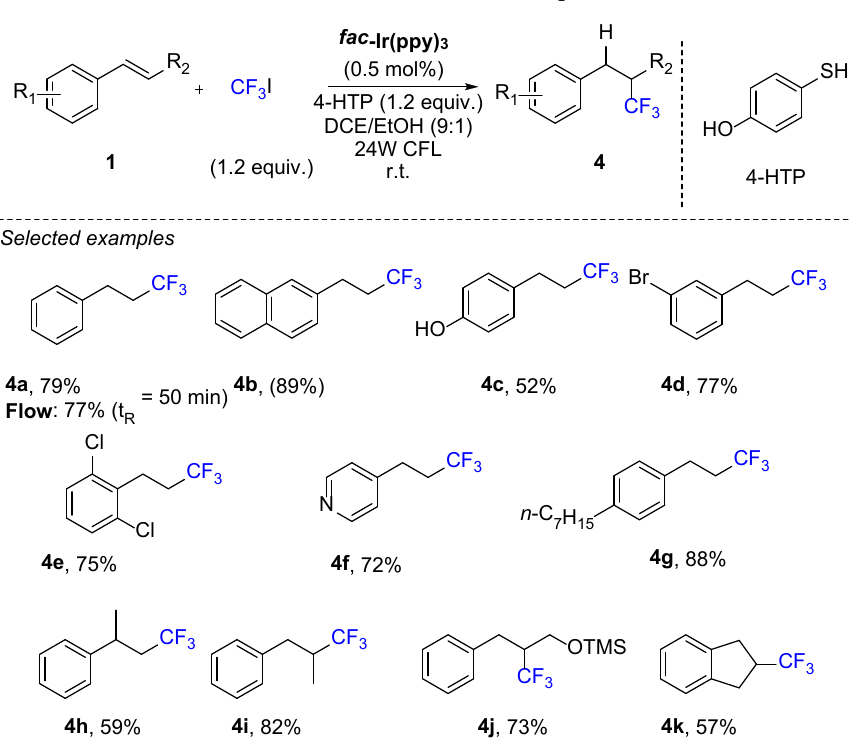
rene derivatives. Their visible light protocol is based on the use of CF 3 I as a trifluorometh- ylation reagent in the presence of fac-Ir(ppy) 3 photocatalyst upon 24W CFL [16]. Herein, 4-hydroxythiophenol (4-HTP) was used as H-atom donor (Figure 2). The desired com- pounds were obtained in very good to excellent yields and the reaction conditions toler- ated the presence of several functional groups, including free alcohols ( 4c ), halogens bromo ( 4d ) and chloro ( 4e ), as well as heterocyclic starting materials such as 4-vinylpyri- dine ( 4f ). Interestingly, the authors demonstrated that the hydrotrifluromethylation could time from 18 h to 50 min with similar reaction outcome (product 4a obtained in 77% yield).